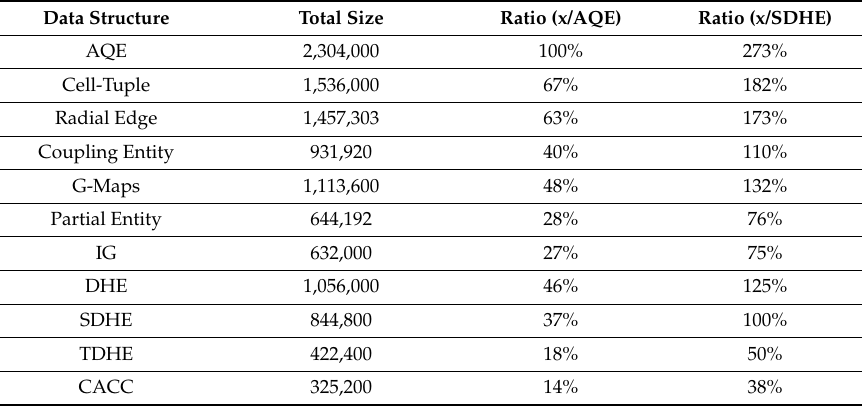
Figure 12. Storage (in bytes) comparison of different data structures with CACC. Table 1. Data storage ratio comparison (in bytes) with AQE and